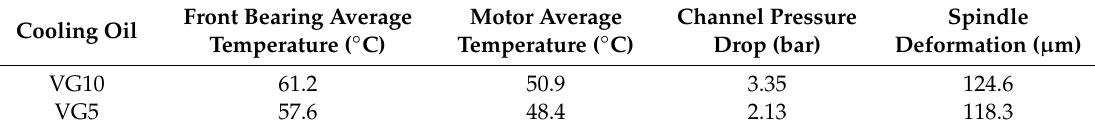
Table 2. Simulation analysis results of di ff erent oil